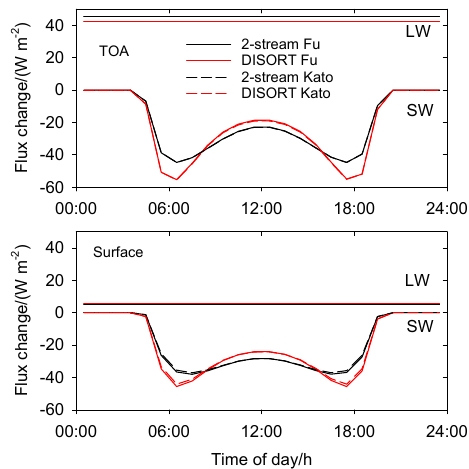
Figure 3. LW and SW flux changes versus time of day at TOA and at the surface, for two-stream and DISORT solvers, and for Fu and Liou and Kato shortwave molecular absorption parameteriza- tions. The model parameters are the same as in Fig. 2, τ = 0 . 5. The flux differences for different molecular absorption models of Fu and Kato are far smaller than between the two-stream solver and DIS- ORT.